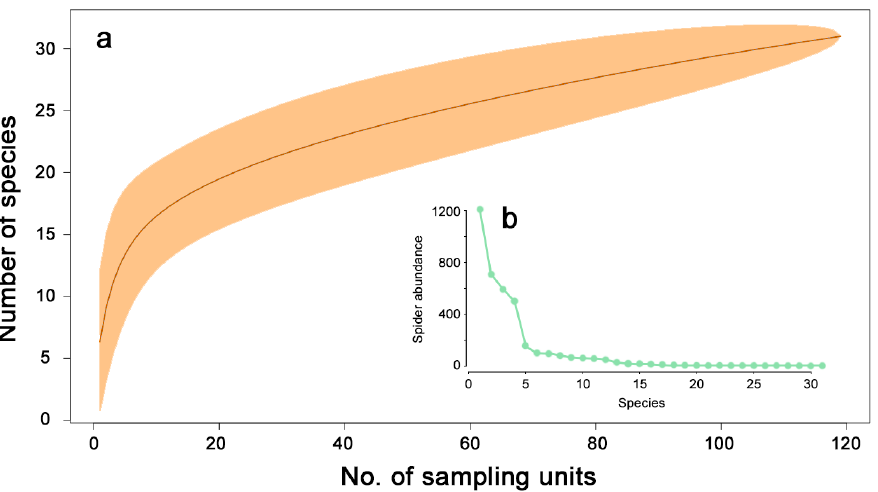
Figure 2. Species richness estimation ( a ) by Mao Tau estimator with 95% confidence intervals and ( b ) the rank abundance plot for the whole spider assemblage captured in pitfall traps.